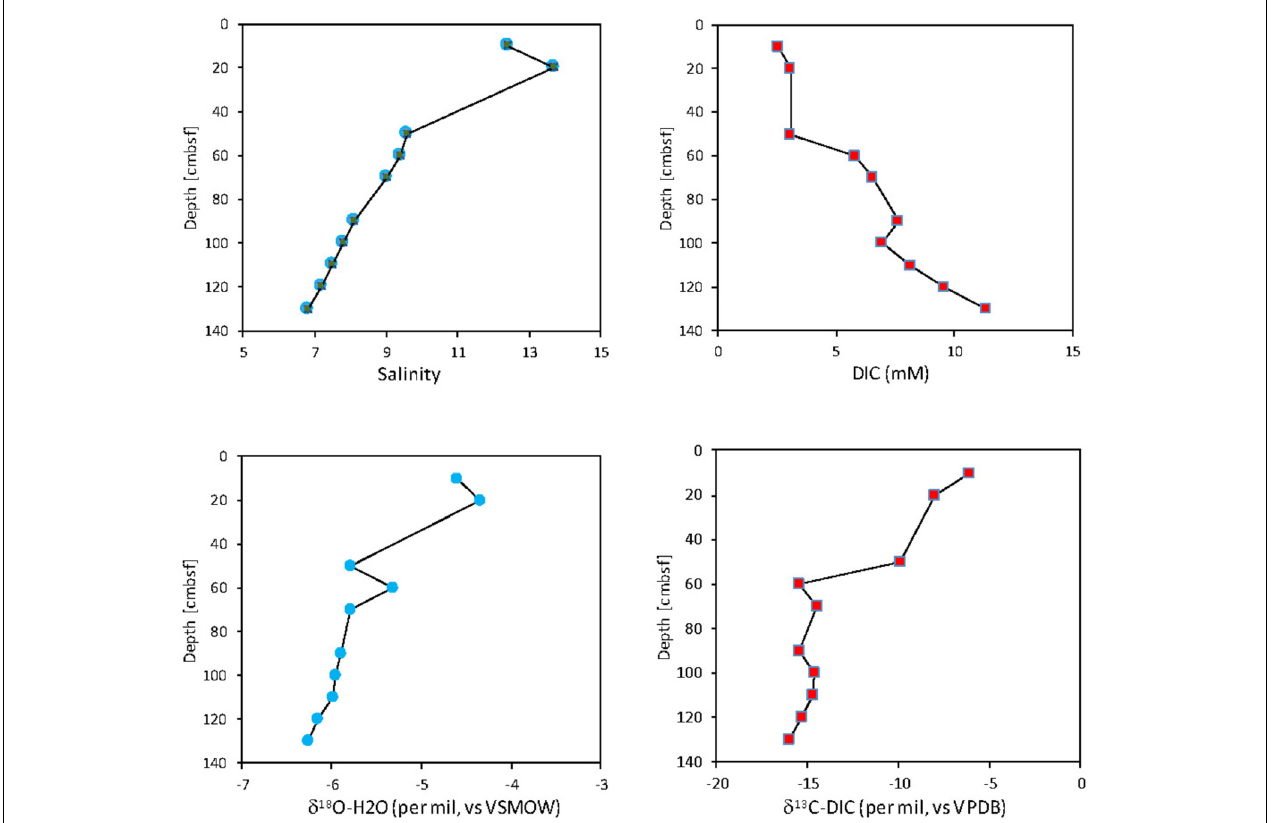
FIGURE 10 | Examples for vertical profiles of the pore water composition at a submarine groundwater discharge (SGD) impacted site (taken with a mobile pore water lance in spring 2017). Whereas the water isotopes and salinity (PSU) indicate the contribution of fresh and isotopically lighter water at depth, the dissolved carbonate system shows a clear contribution of biogenic CO 2 derived from the anaerobic mineralization of essentially marine organic matter. Dissolved sulfide, the product of microbial sulfate reduction, accumulated about 40 cm below sea floor and also phosphate and silica were substantially enriched in the pore waters when compared to surface